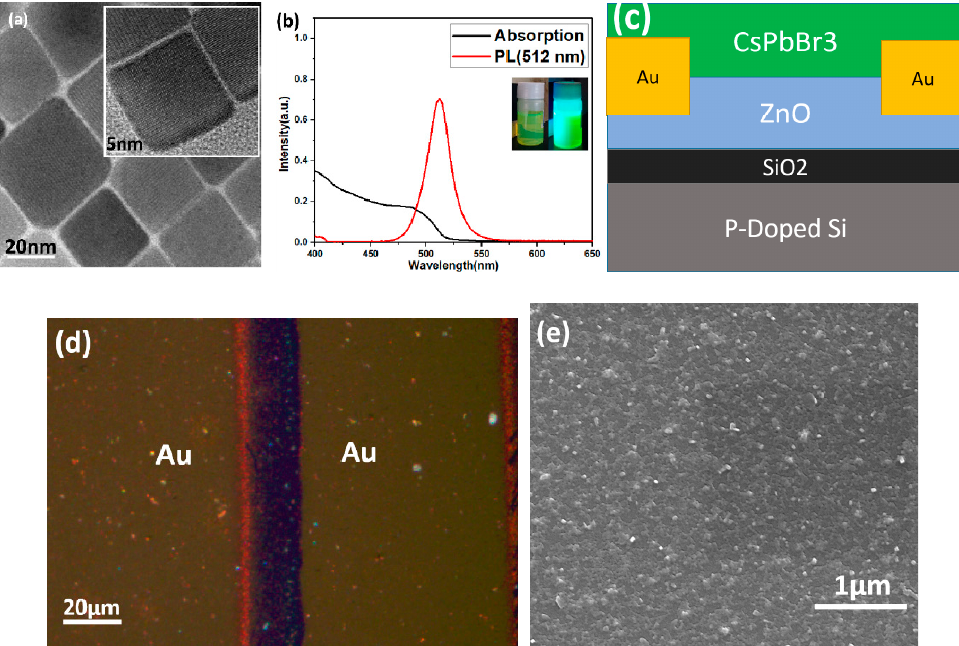
Figure 4. ( a ) Low-resolution TEM image of the CsPbBr 3 QDs. [Inset: the corresponding high-resolution image]. ( b ) The absorption and PL spectra of the CsPbBr 3 QDs. [Insert: the photographs of CsPbBr 3 QD without (left) and with (right) 365 nm light excitation]. ( c ) Schematic illustration of the phototransistor. ( d ) Optical image of the phototransistor. (e) SEM image of CsPbBr 3 QDs film on ZnO QDs film.